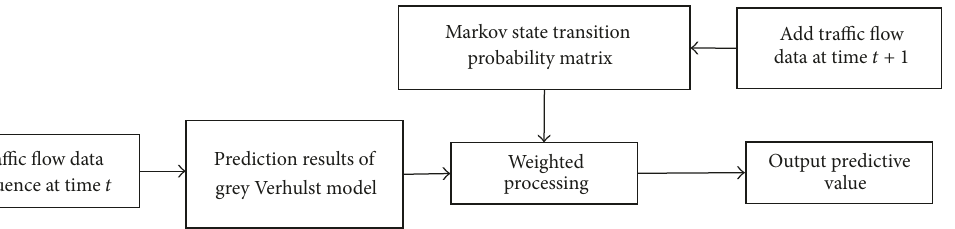
Figure 1: Grey forecasting model based on Markov chain.